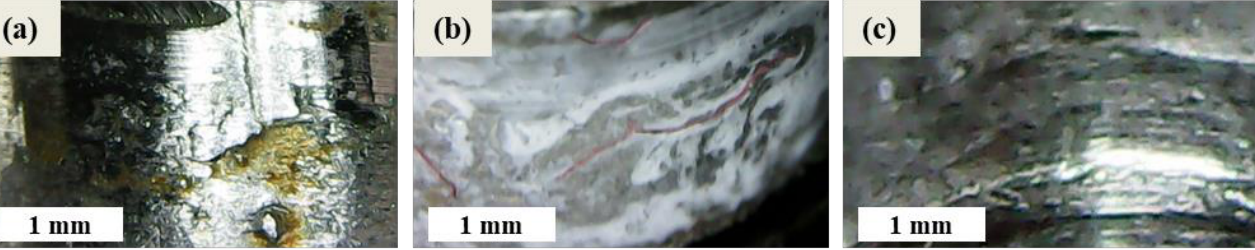
Figure 10. Inner hole surfaces of ( a ) untreated ( b ) picosecond laser-treated ( c ) nanosecond laser-treated material.